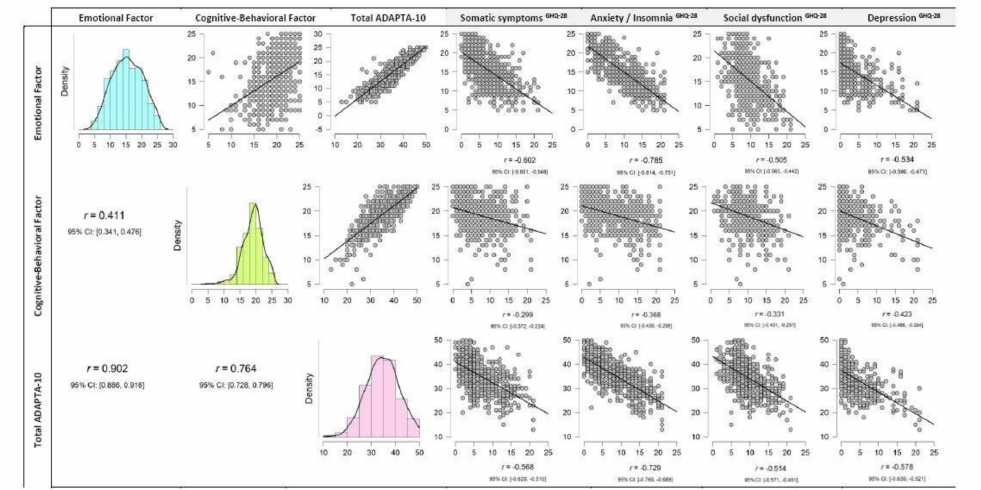
Figure 4. ADAPTA-10 questionnaire correlations and General Health